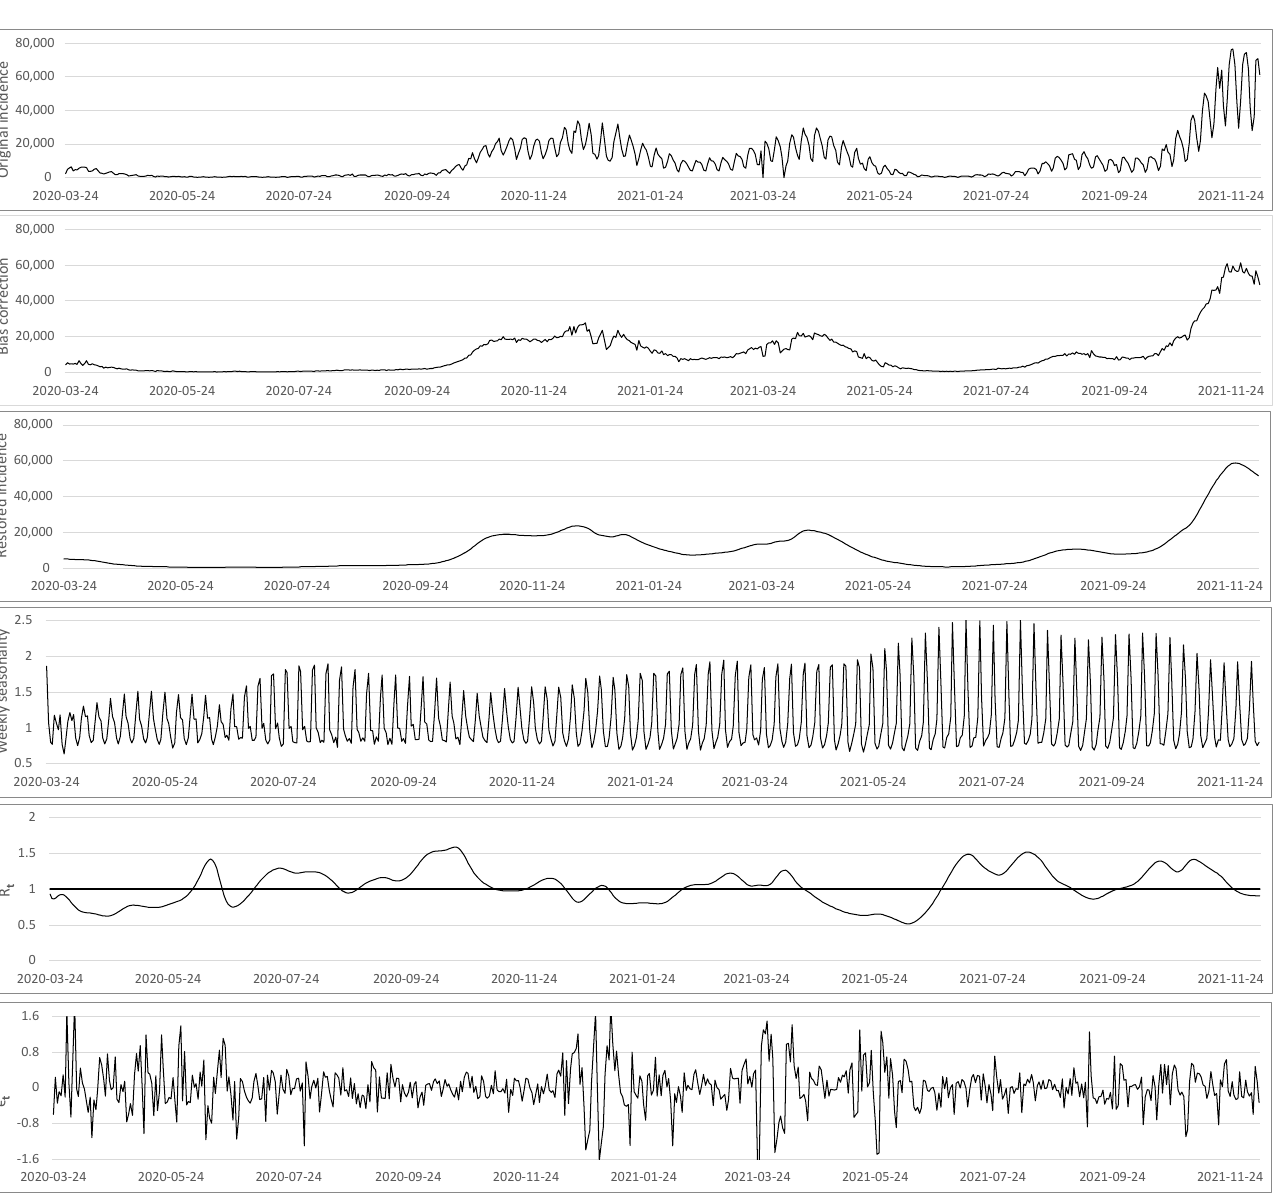
, (ii) the incidence curve t , (iv) the weekly t